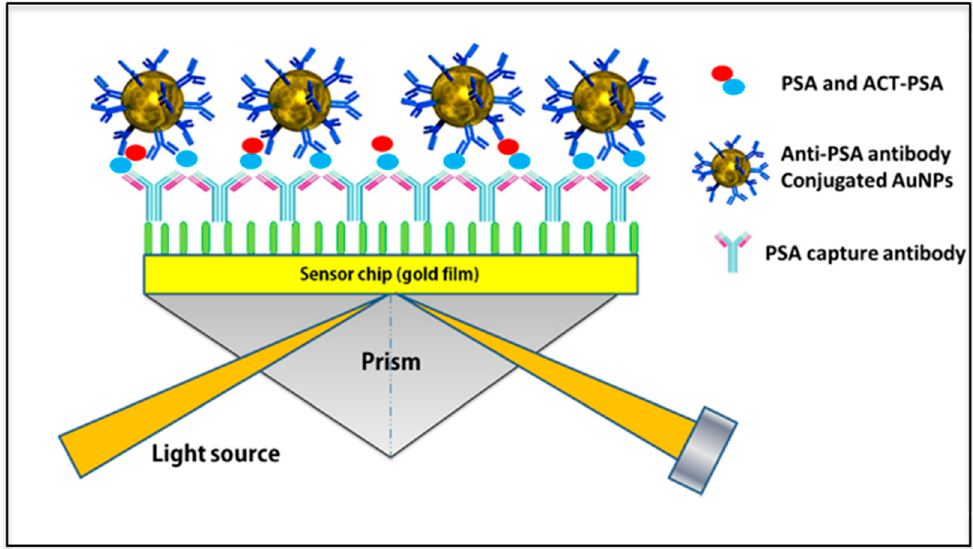
Figure 9. Schematic of SPR configuration used in the detection of PSA. (Reproduced from Ref. [105] with permission from MDPI)